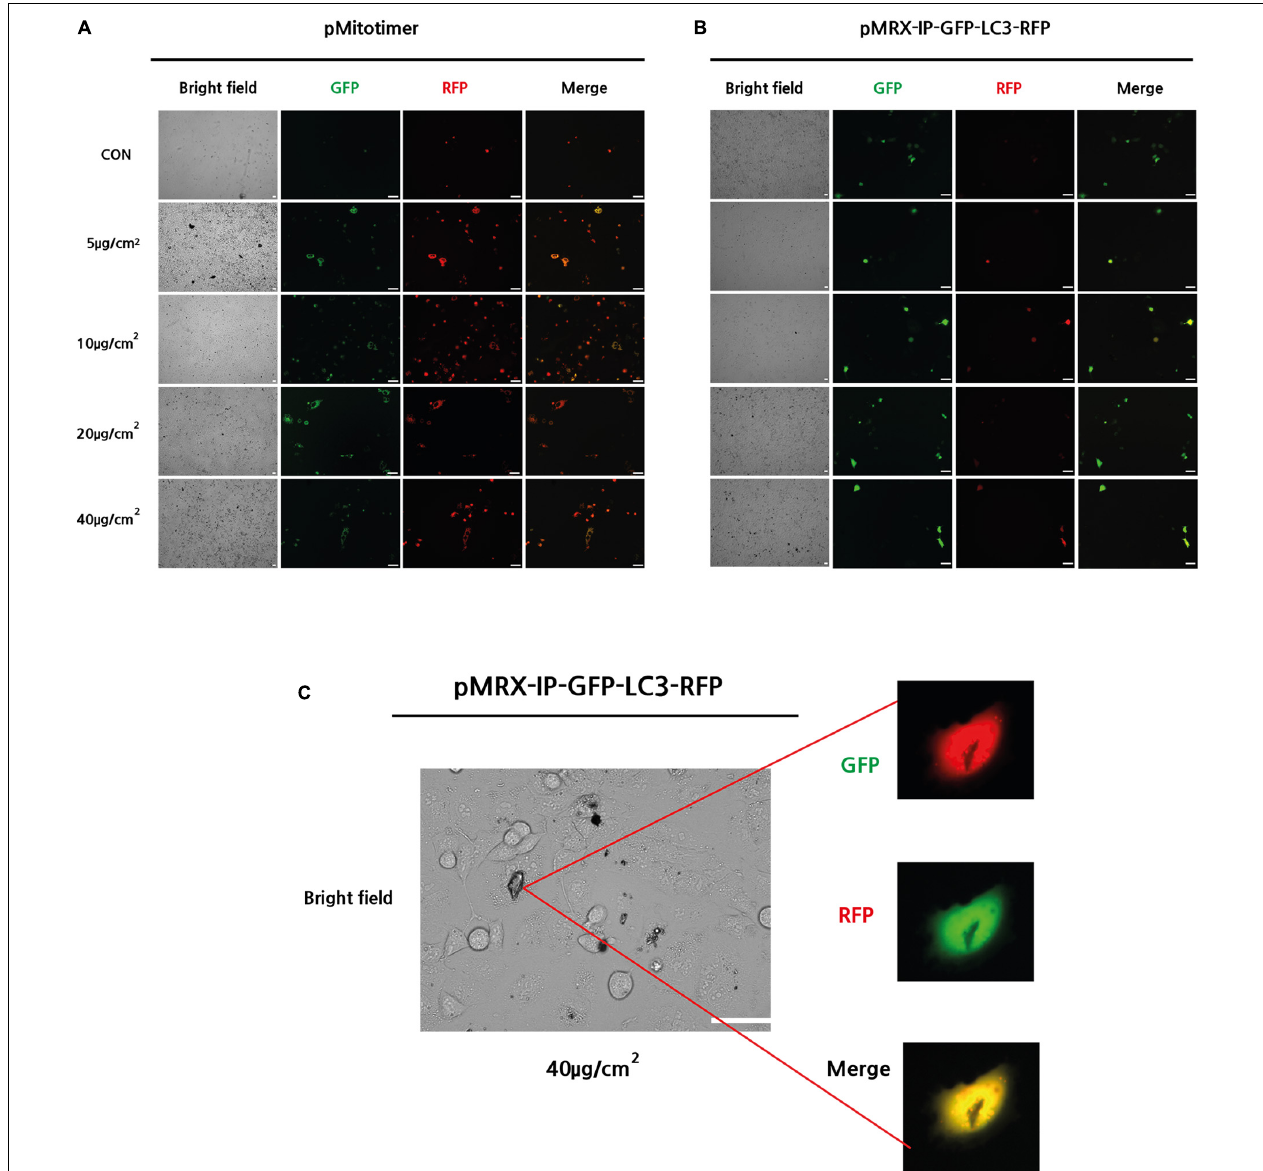
FIGURE 2 | Exposure to PM-induced mitochondrial damage and autophagy in A549 cells. (A) Representative images of MitoTimer fluorescence spectrum shift in response to PM induce mitochondrial oxidation. (B,C) Representative images of pMRX-IP-GFP-LC3-RFP transfected cells during PM-induced autophagy. (Scale bar = 50 µ